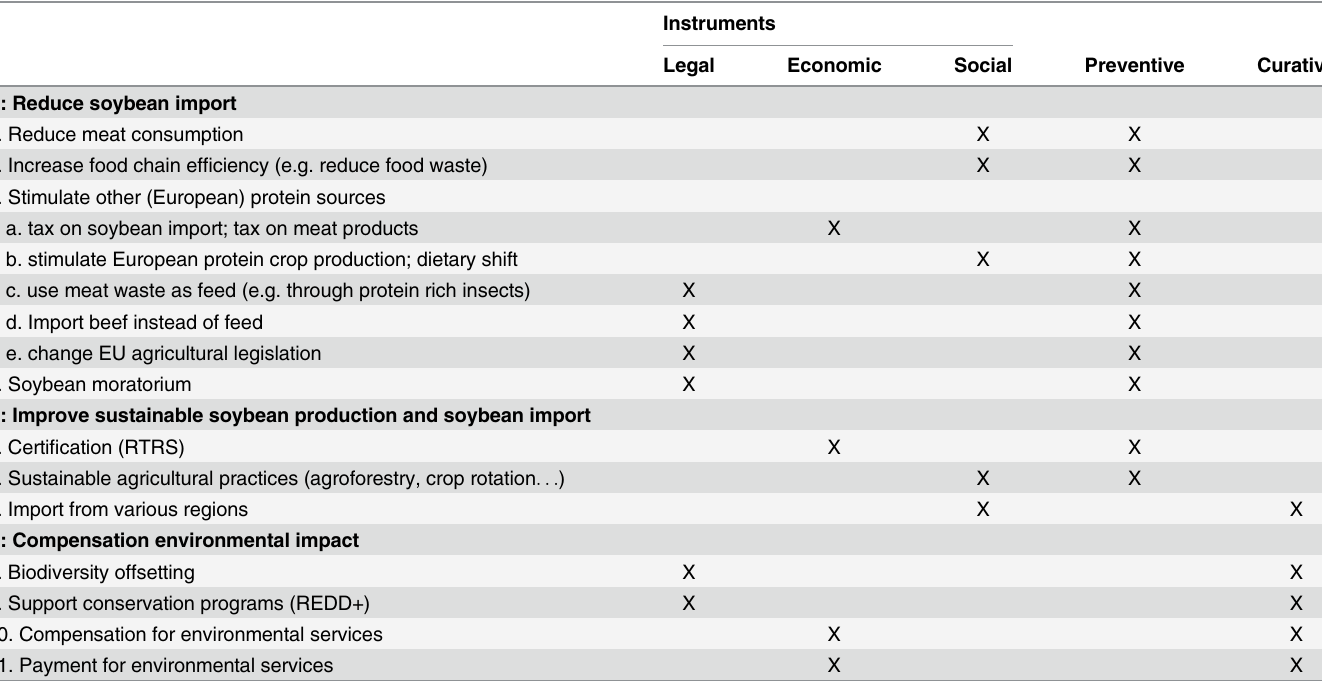
Table 2. Overview possible actions at different policy